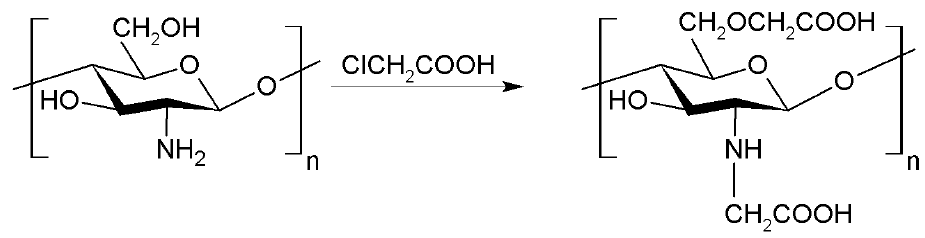
Figure 6. Reaction of chitosan O- and N- carboxymethylation.